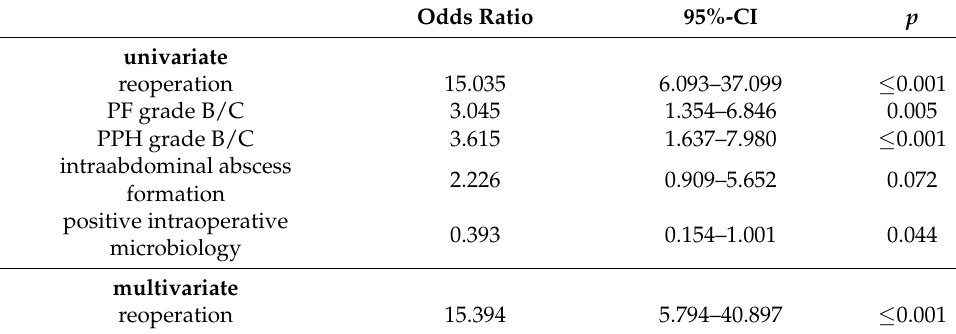
Table 4. Risk factors associated with high